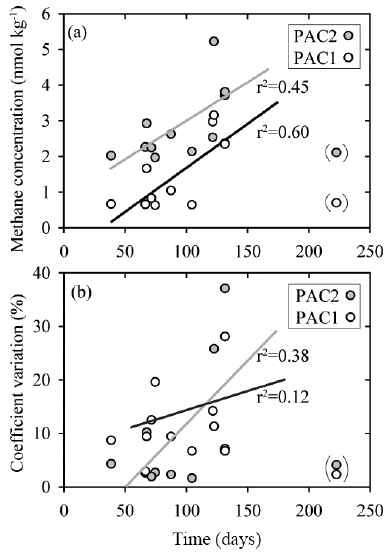
Figure 7. Comparison of sample storage times with measured con- centrations of methane (a) and coefficient of variation (b) for two sets of seawater samples (PAC1 and PAC2) collected in Febru- ary 2017. These two sets of seawater samples had the lowest methane concentrations and appear to be influenced by the dura- tion of storage time. The data points enclosed in parentheses were not included in the regression analysis. The PAC1 regression line is black and the PAC2 regression line is grey. All of the storage times are included in the